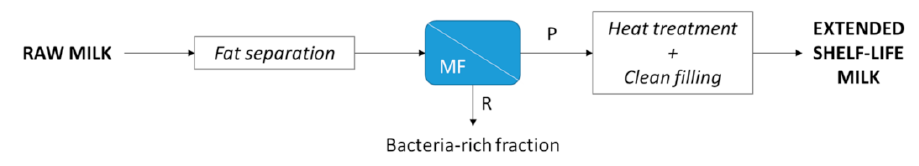
Figure 4. Process description for extended shelf life milk production (adapted from